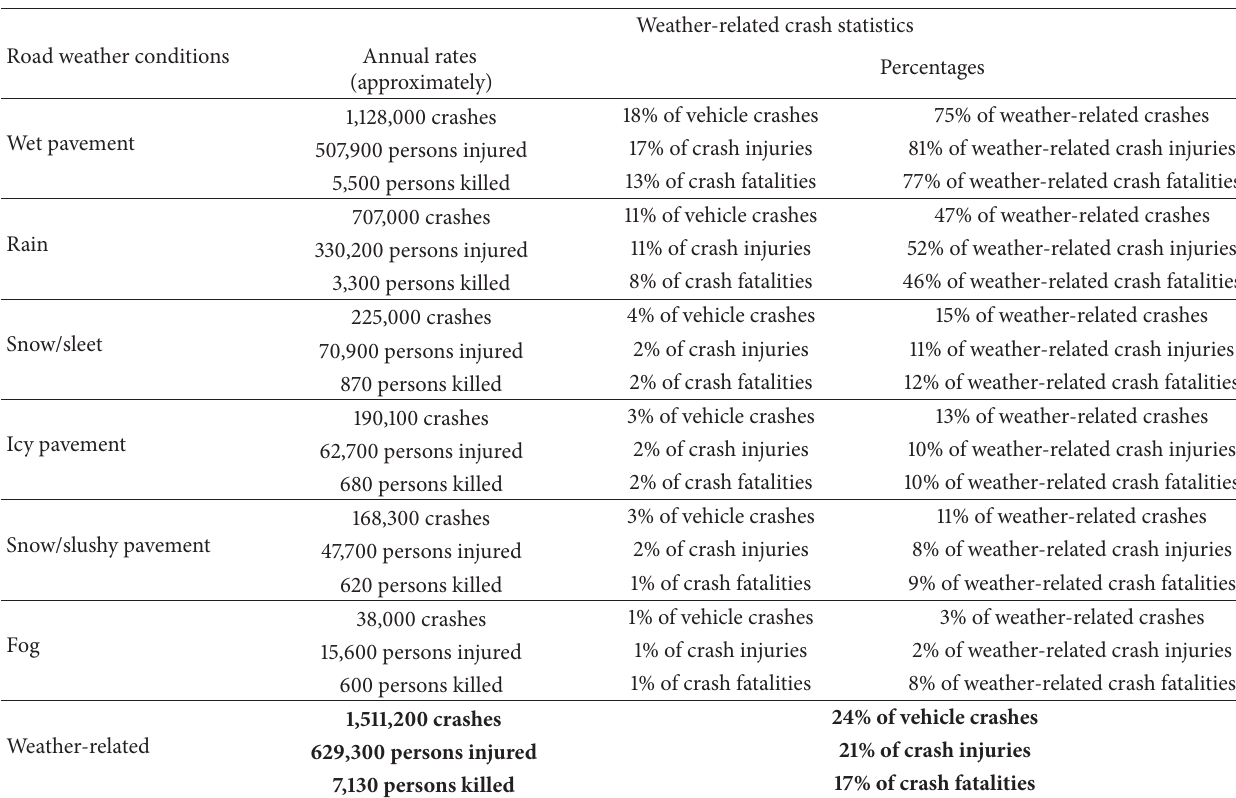
Table 1: Weather-related crash statistics (annual averages 1995–2008)